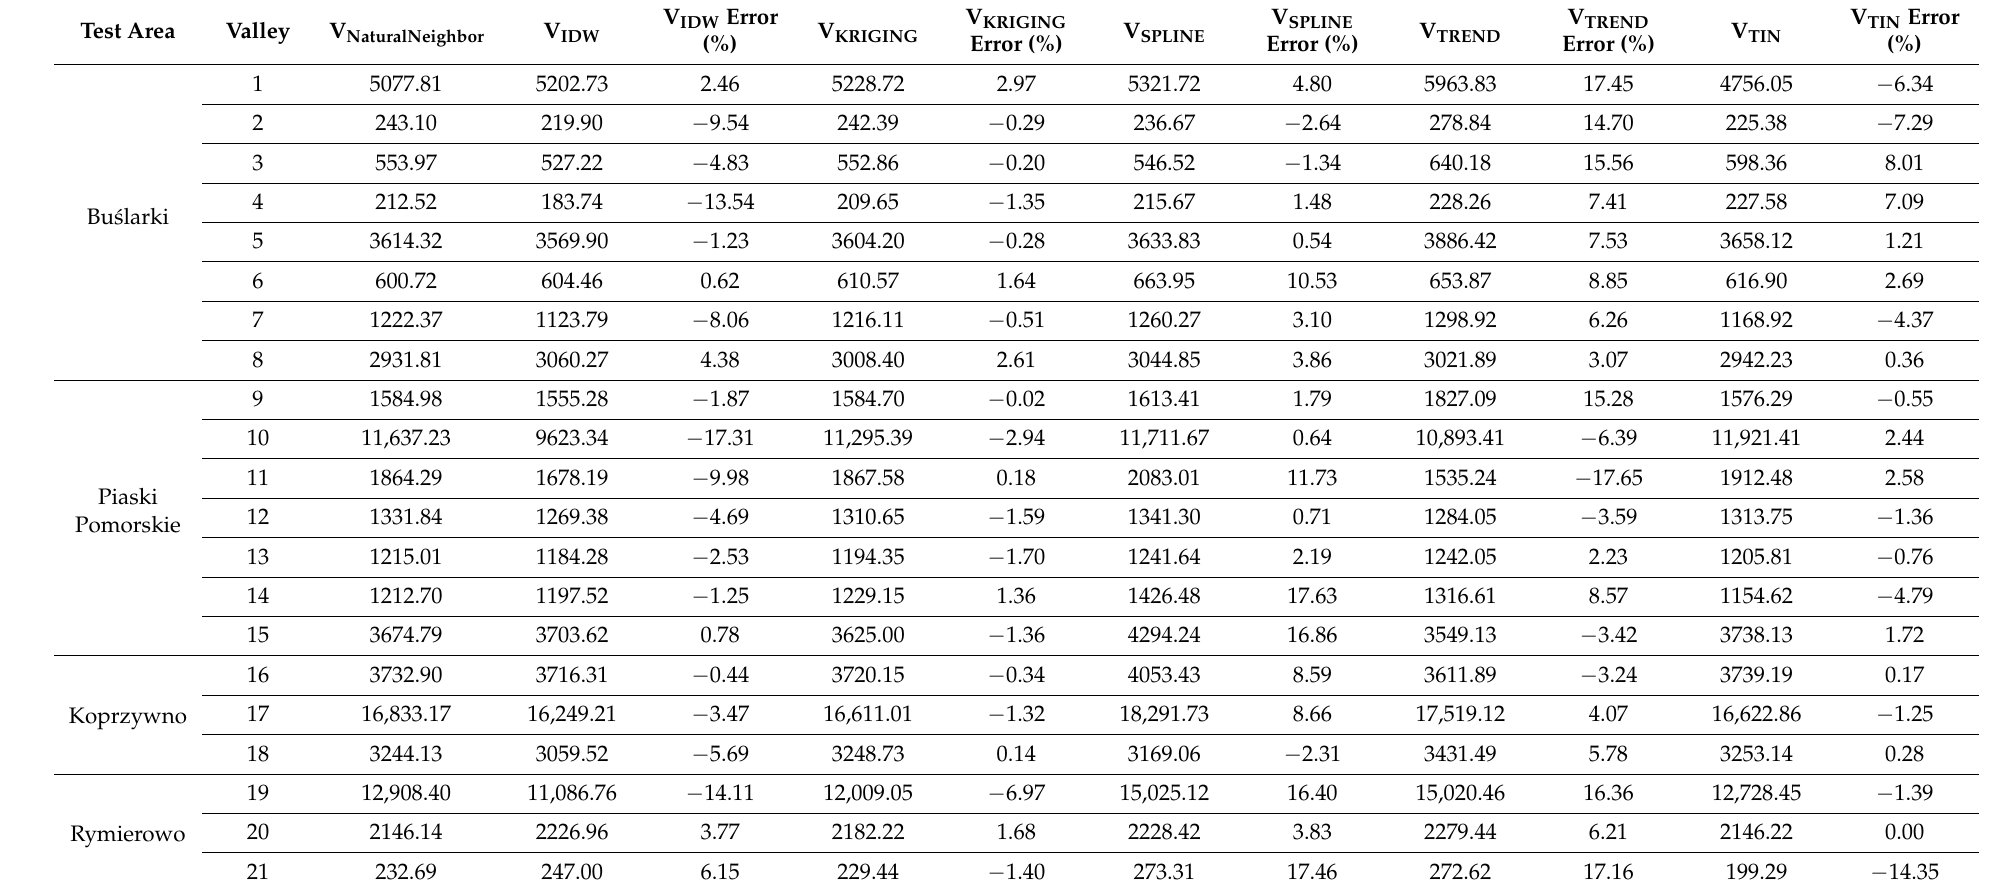
Table 8. Volumetric parameter according to the overlay DEM interpolation